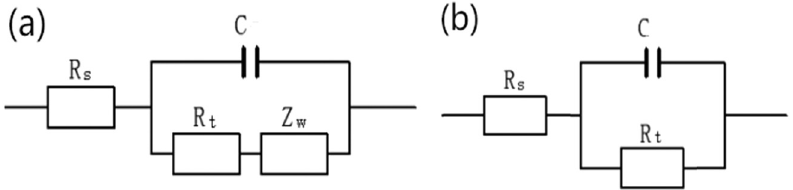
Figure 10: Equivalent circuit diagrams used for ( a ) Nyquist plots with Warburg impedance and ( b ) Nyquist plots composed of capacitive loops.